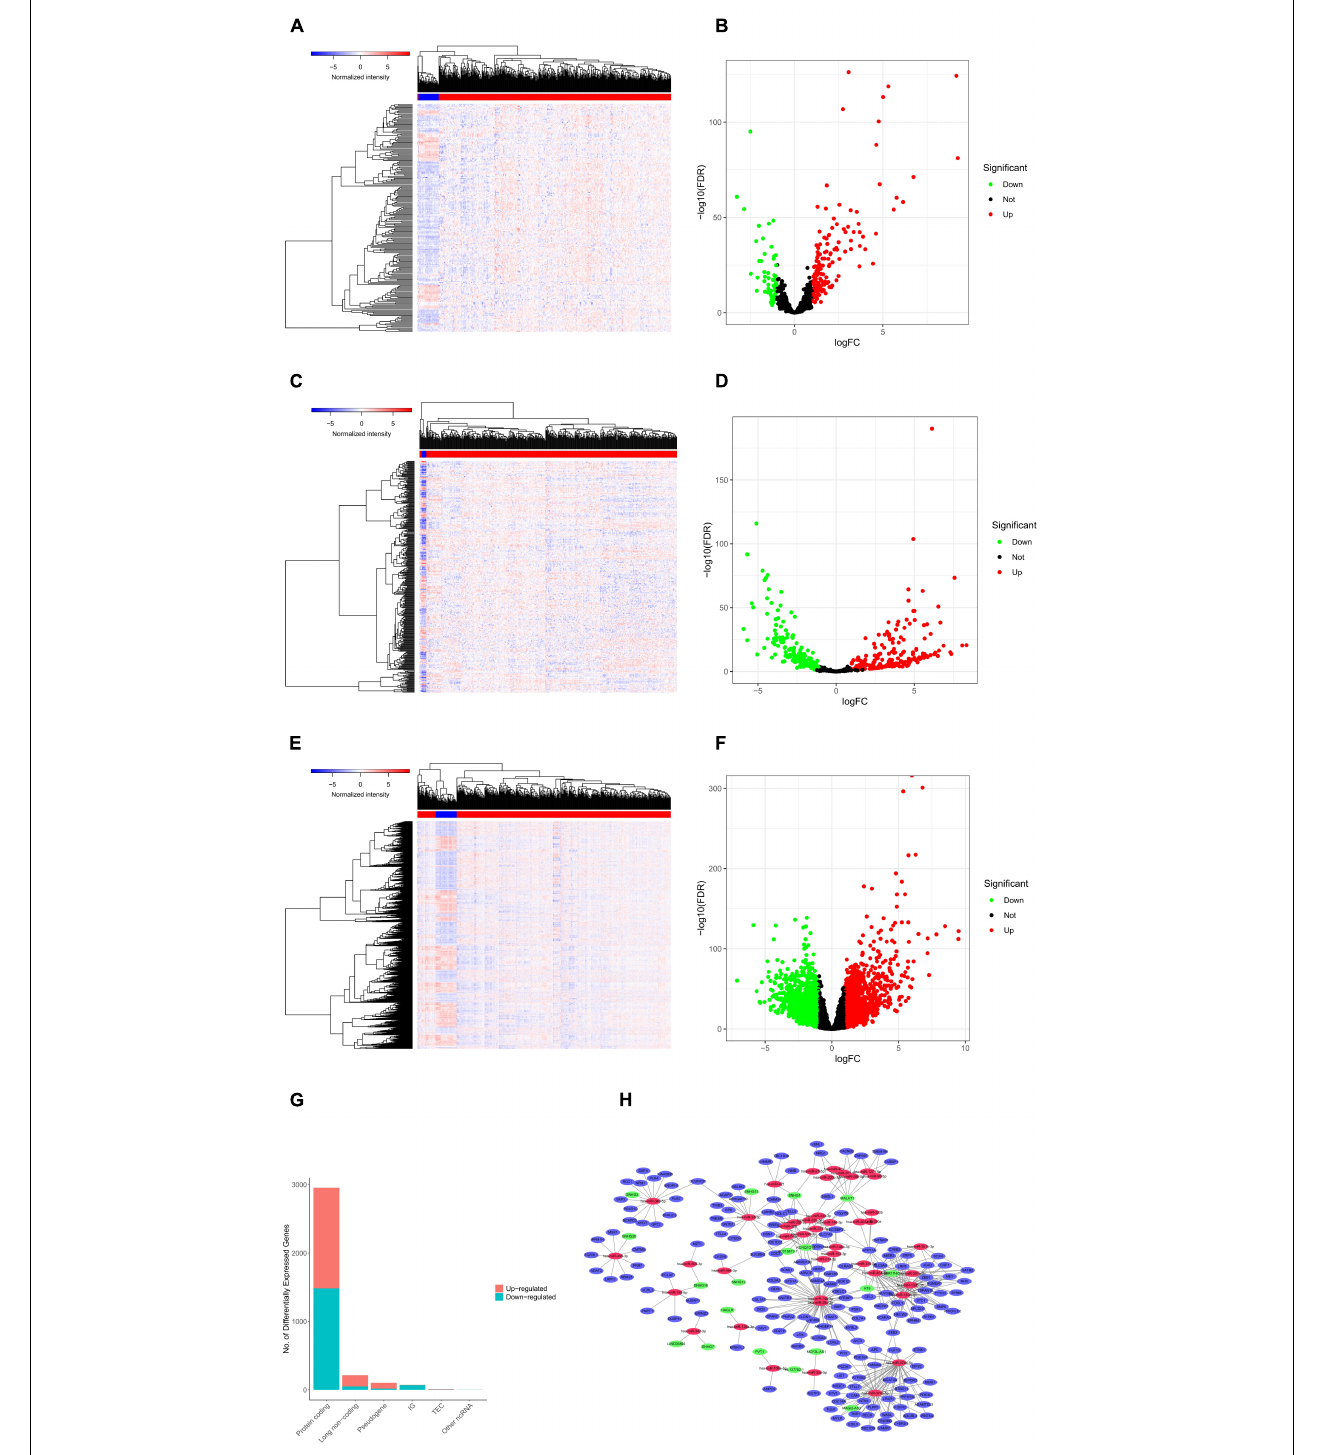
FIGURE 1 | (A) Heatmap of differentially expressed lncRNAs in colon cancer. (B) Volcano map of differentially expressed lncRNAs in colon cancer. (C,D) Differentially expressed in colon cancer heatmap of miRNA. (E,F) Heatmap of differentially expressed mRNA in colon cancer. (G) Statistics of the upregulation of differentially expressed RNA. (H) Differential ceRNA regulatory network in colon